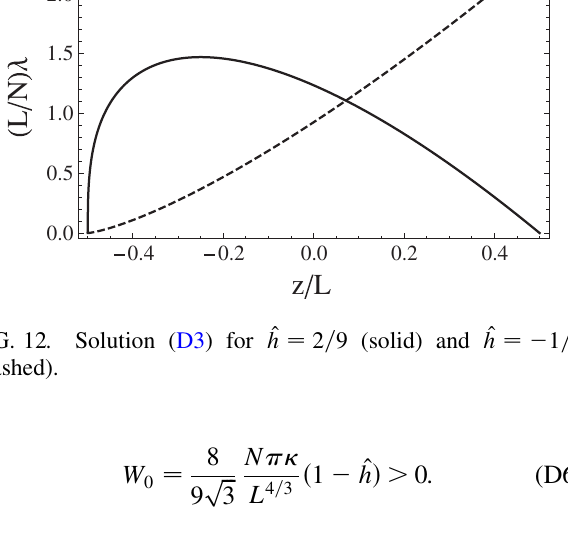
FIG. 12. Solution (D3) for